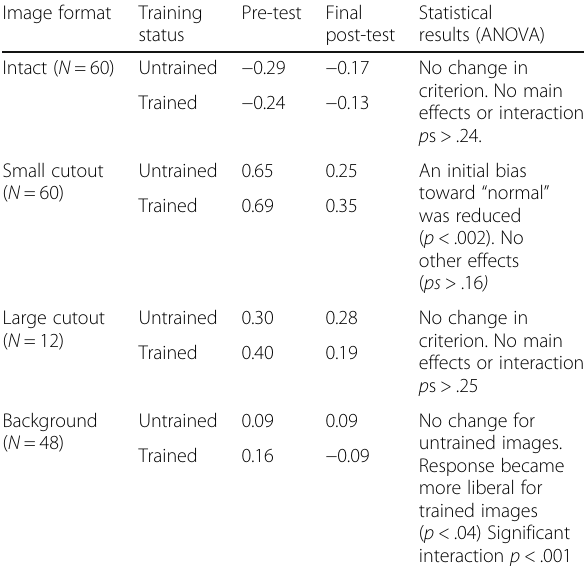
Table 5 Response criterion in the pre-test and final